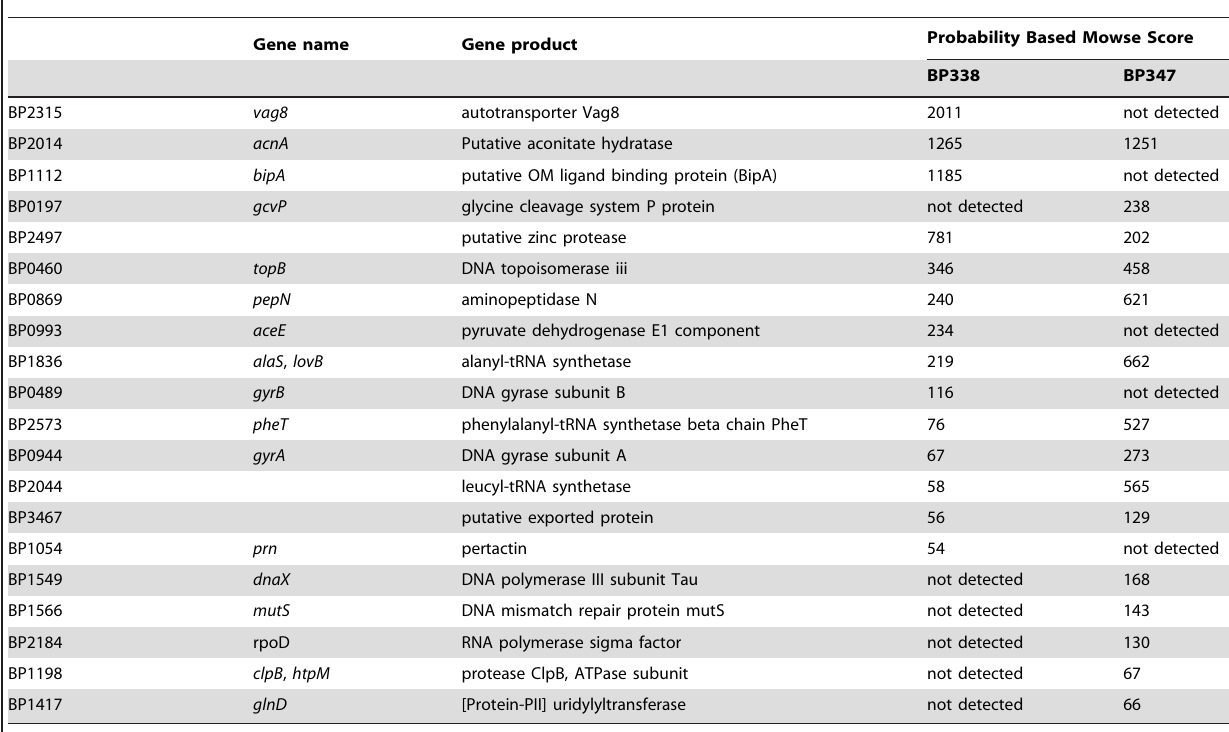
Table 1. Genes encoding the proteins that were identified by tandem mass